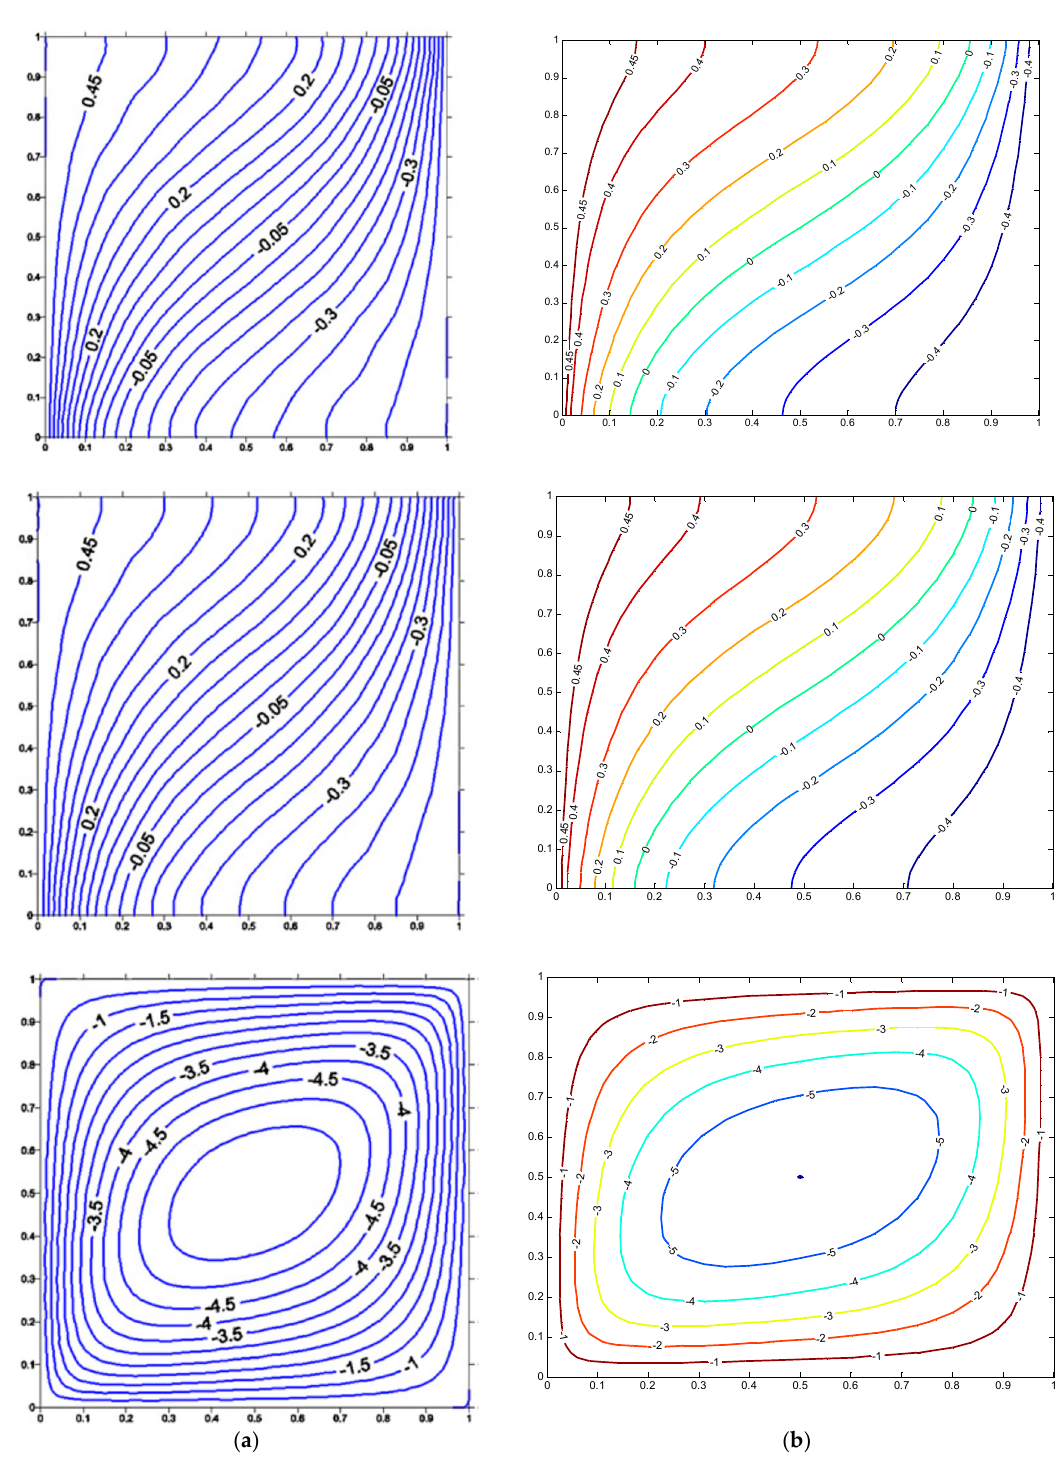
Figure 5. Isotherms for fluid (Top), solid (Middle), and streamlines (Bottom) at Ra = 100 , R d = 0.5 , Kr = 1 , H = 1000, ( a ) Ref [27] ( b ) Present.